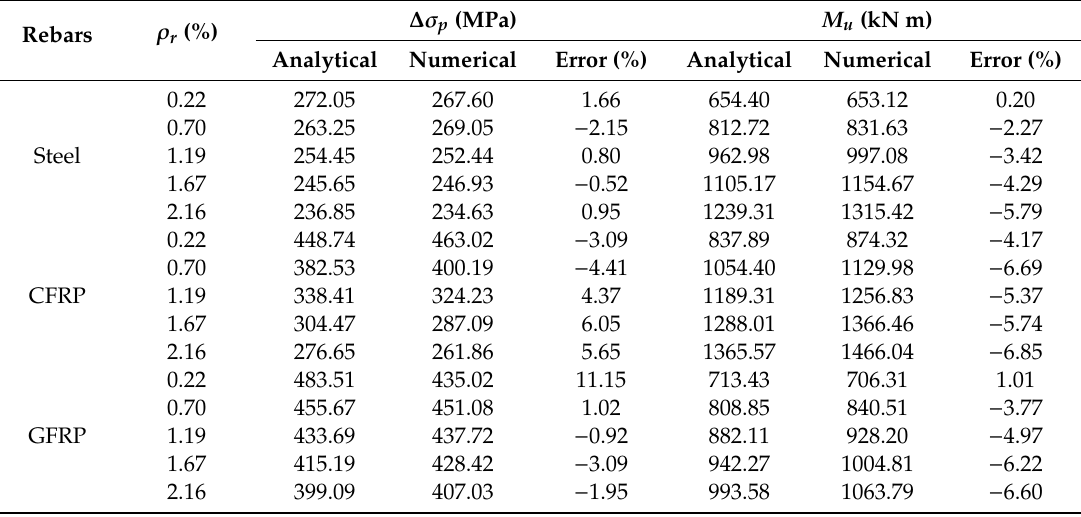
Figure 12. Comparison between analytical predictions and numerical results. ( a ) tendon stress increment at ultimate; ( b ) ultimate moment. Table 3. Comparison of ultimate tendon stress increment and moment predicted by the analytical model with numerical results.